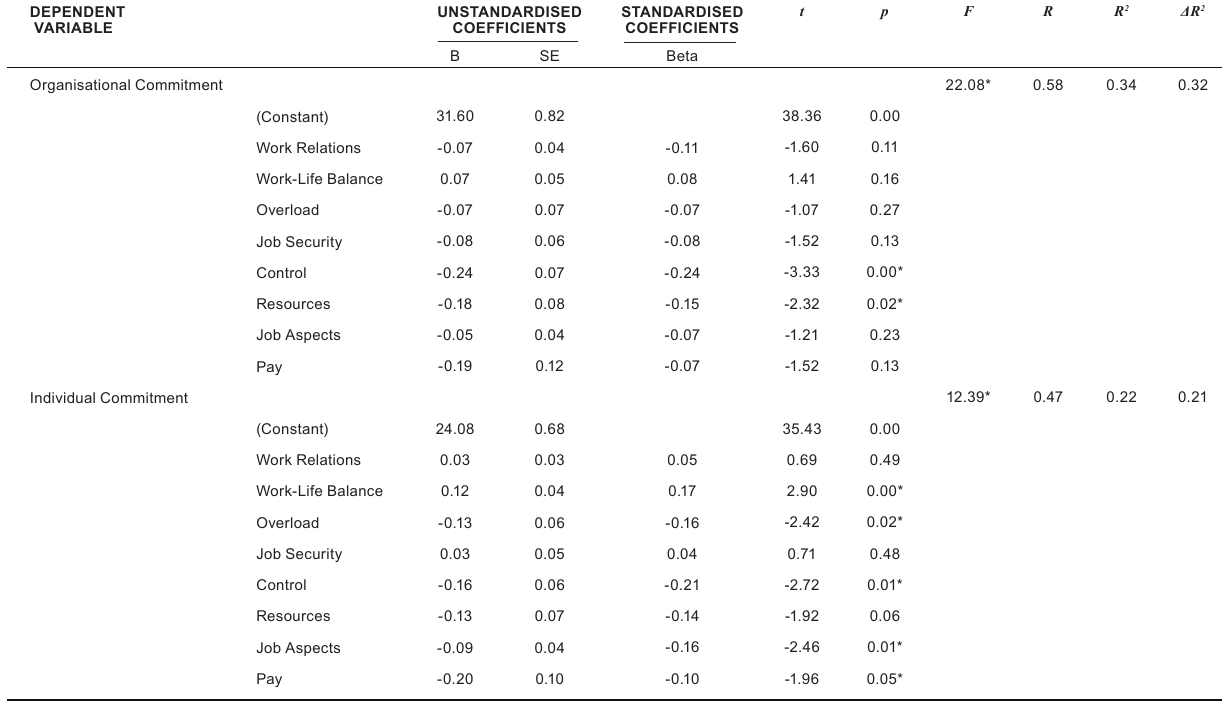
taBLe 4 Standard multiple regression analysis with organisational and individual commitment as dependent